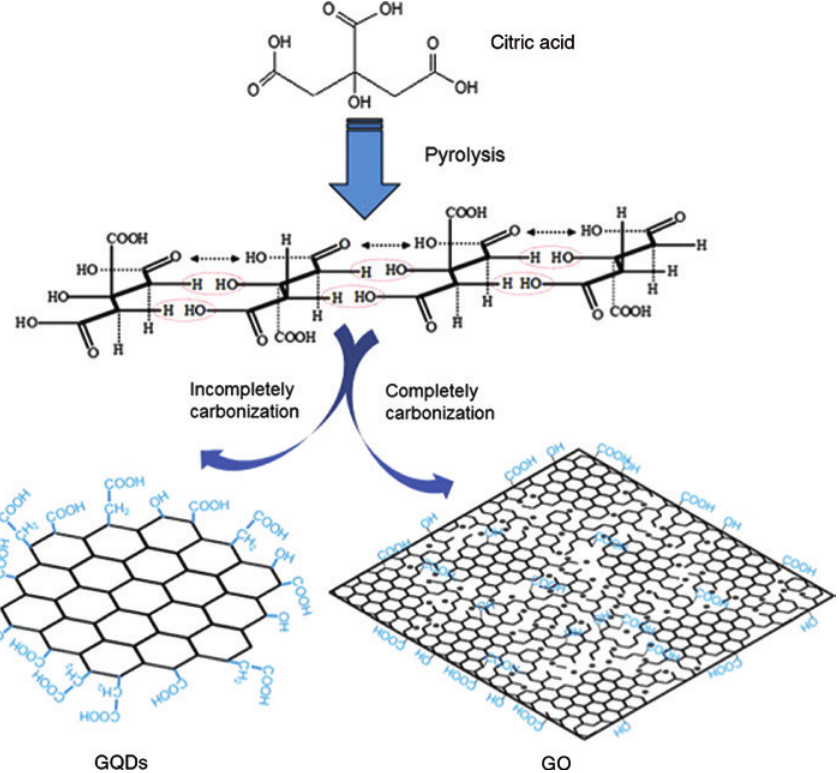
Figure 16: Diagram for the synthesis of GQDs and GO. The black dots in the GO represent oxygen atoms (reprinted/reproduced with the permission of Ref. [75], copyright 2012, Elsevier